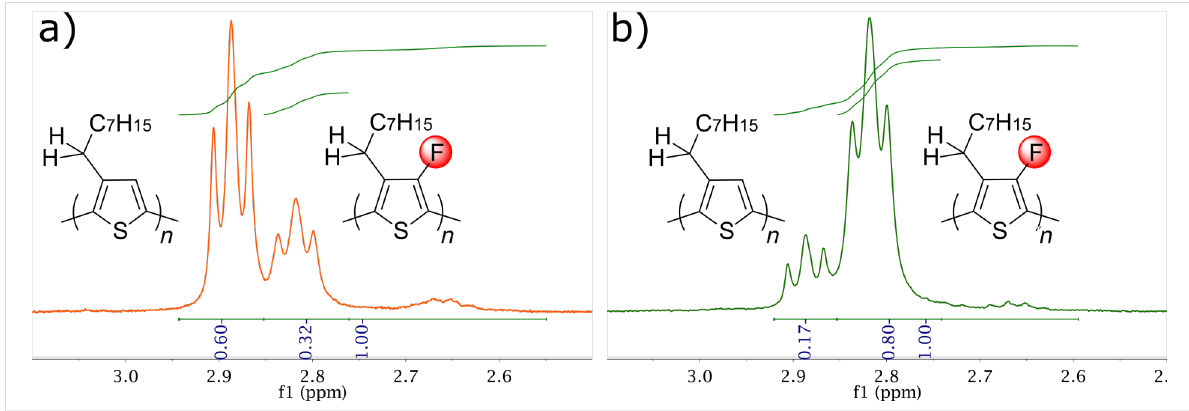
Figure 2: Selected region of the 1 H NMR ( d 2 -TCE at 403 K) of P3OT- b -F-P3OT produced with 3:1 (a) and 1:3 (b) monomer feed ratios. The signals correspond to the methylene protons adjacent to the thiophene